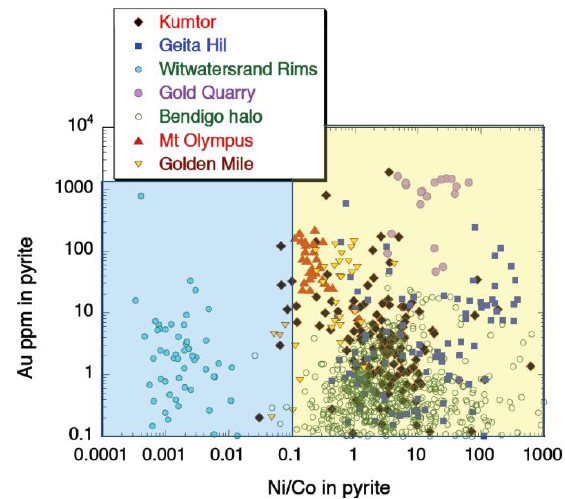
Figure 14. Variation in Au content with Ni / Co ratio in pyrite. Most Au-bearing pyrites have Ni / Co > 0.1. The rims on detrital pyrites in the Witwatersrand CLR are the